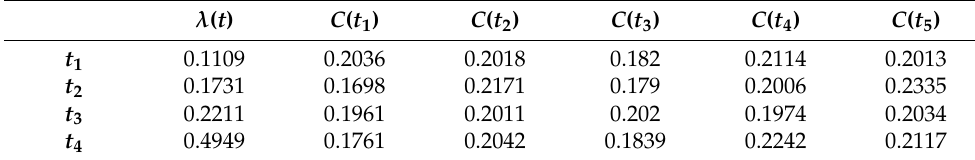
Table 6. Discrete time weight and criteria weight.